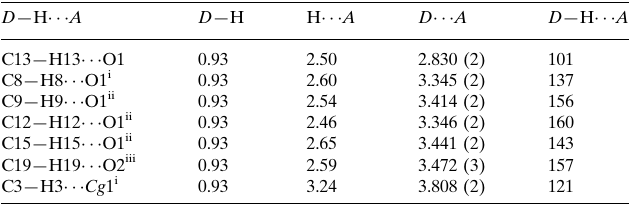
Hydrogen-bond geometry (A˚ , (cid:1) ). Cg 1 is the centroid of the substituted cyclopentadienyl